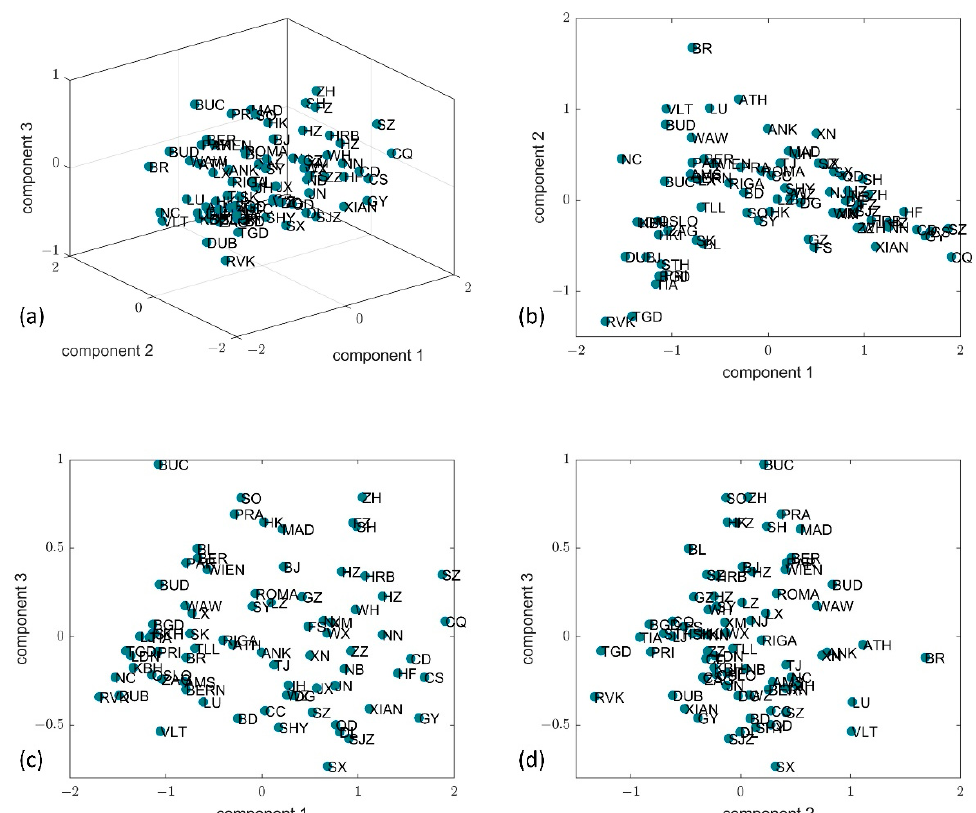
Figure 6. ( a ) Results of the first, second, and third principal components using only traditional build- ing metrics; ( b ) the first component versus second component; ( c ) the first component versus third component; ( d ) the second component versus third component.